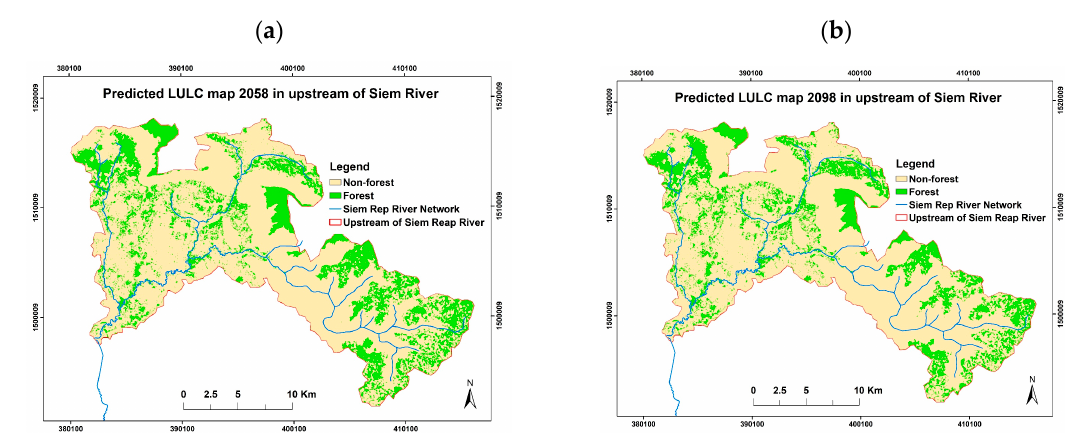
Figure 10. Predicted LULC maps for years ( a ) 2058 and ( b ) 2098.